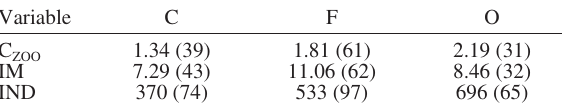
Table 2. – Average values and variability (CV, in parentheses) of C